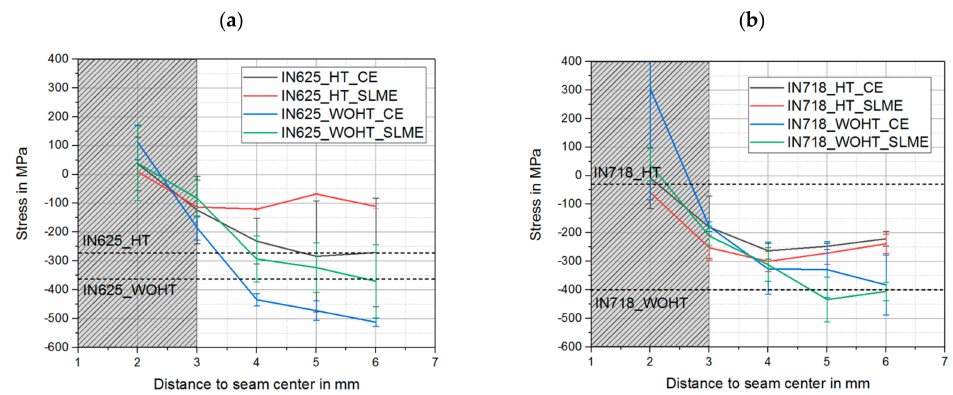
Figure 8. Residual stress profiles adjacent of the weld for both materials: ( a ) IN625 and ( b ) IN718.